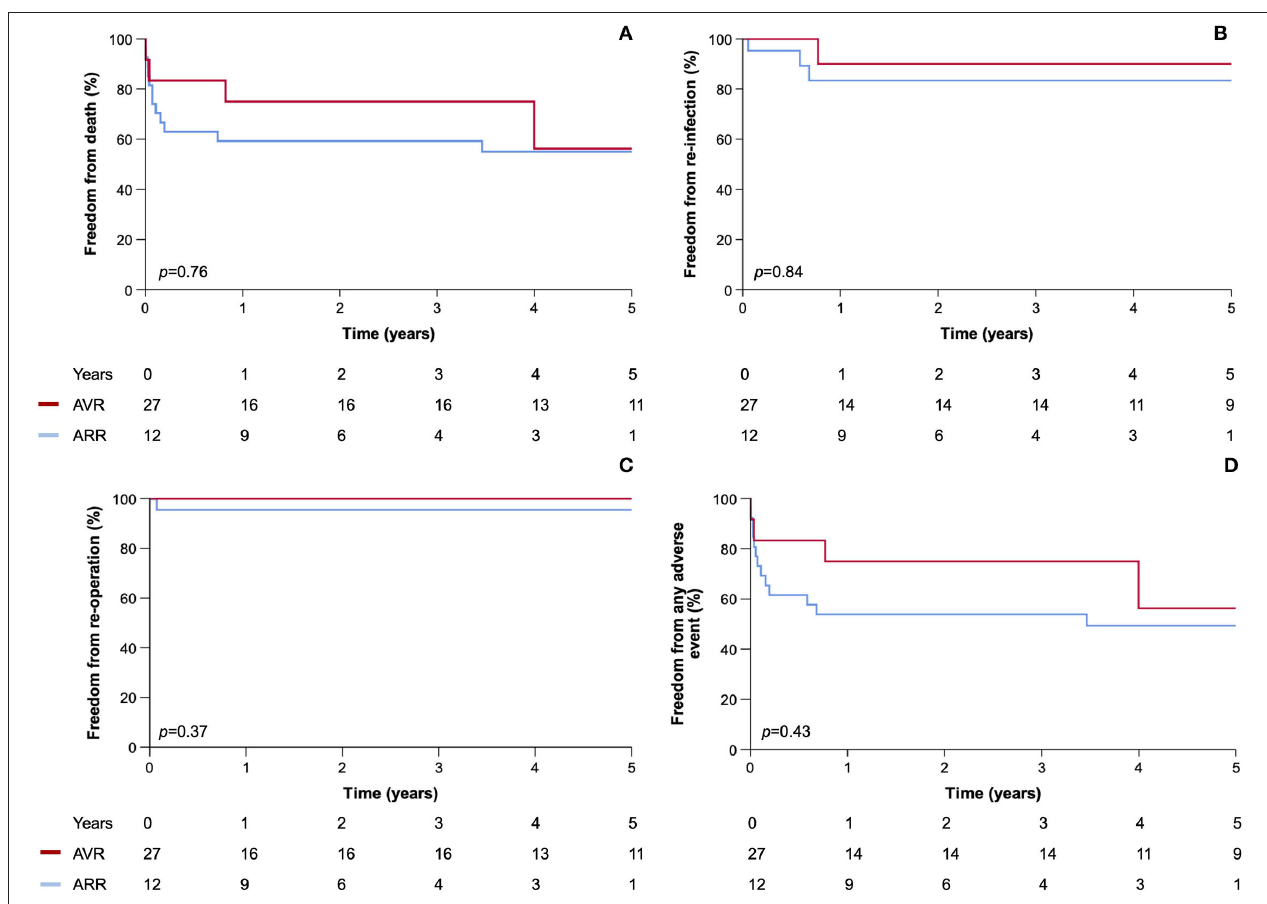
FIGURE 2 | Kaplan–Meier plots of (A) all-cause mortality, (B) relapse/recurrence, (C) re-operation, and (D) any adverse event comparing patients with aortic root abscess undergoing AVR and